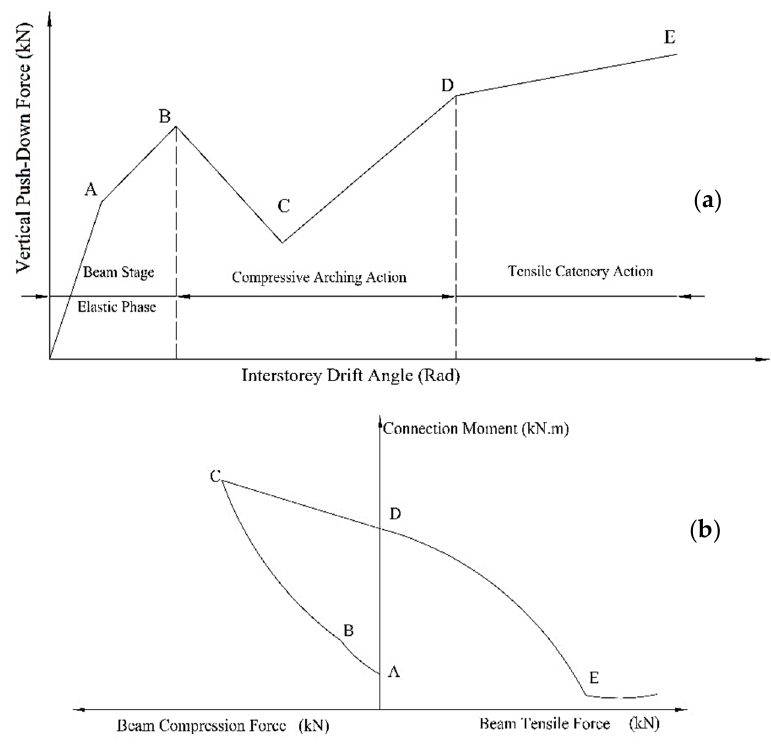
Figure 7. Beam and connection performance following column removal. ( a ) beam nonlinear load-deflection response, ( b ) beam axial load - connection moment interaction